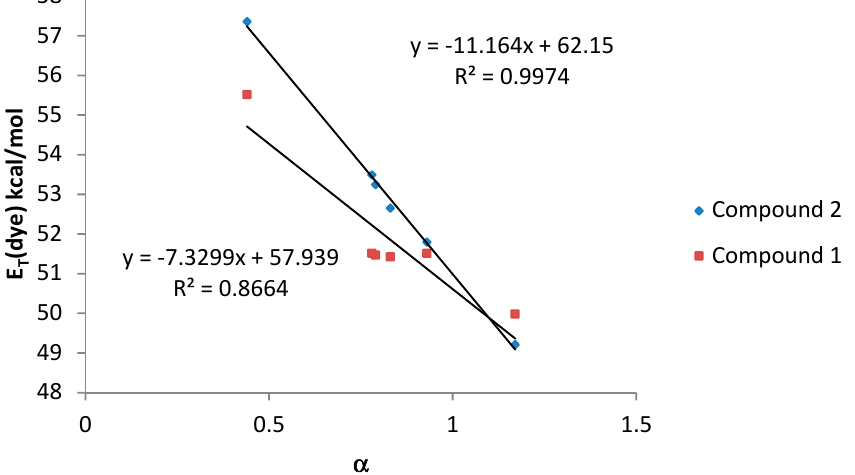
Figure 7. E T (dye) values (kcal · mol − 1 ) for compounds 1 and 2 vs. α values for amphiprotic Figure 6. E T (dye) values (kcal·mol − 1 ) for compounds 1 and 2 vs. α values for amphiprotic (HBA-D) solvents. (HBA-D) solvents.